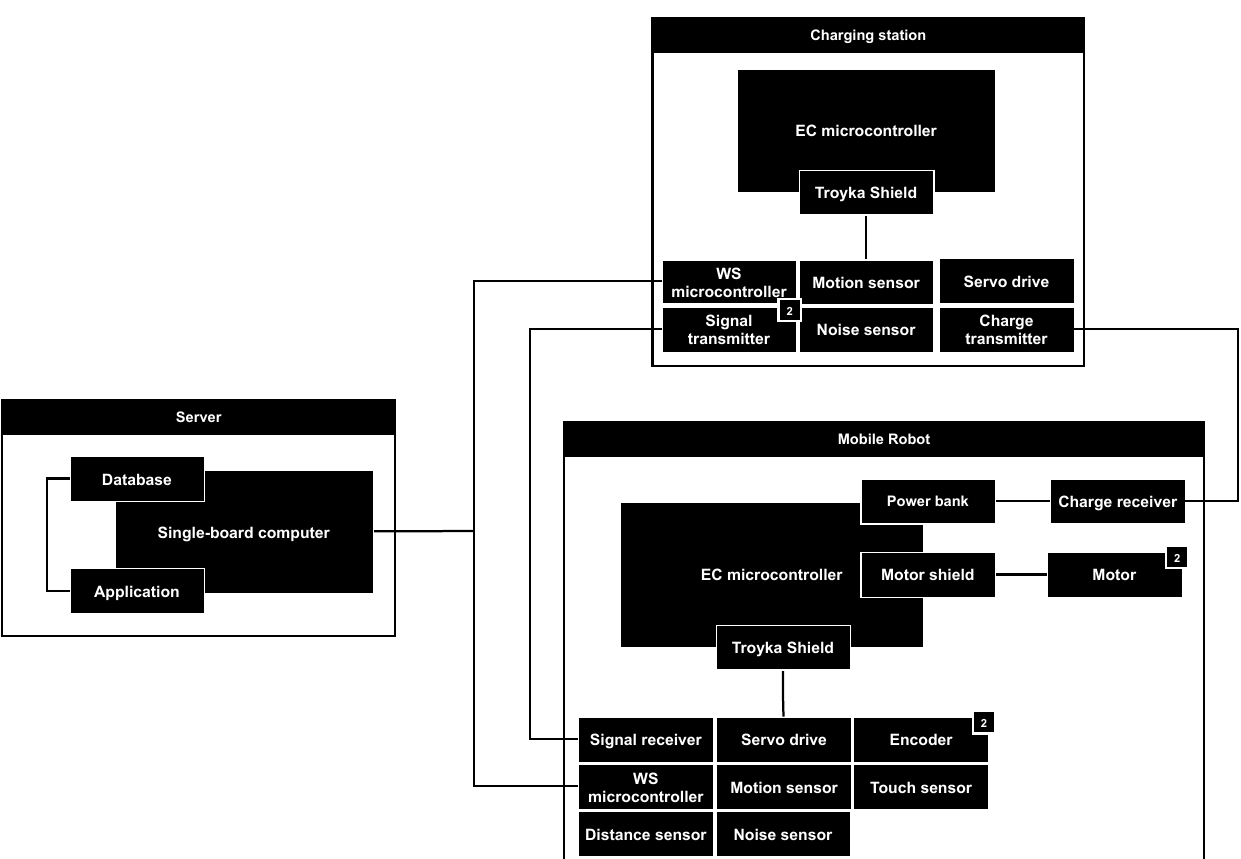
Figure 4. Architecture of the perimeter monitoring